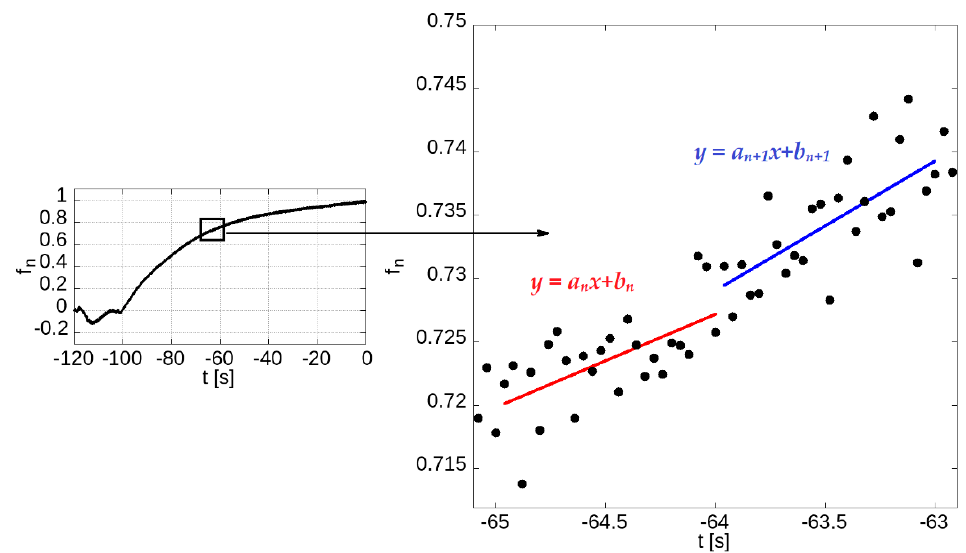
Figure 2. An example of the NADH fluorescence trace with a schematic view of the method for determining the slope coefficients a of the line (where the line equation is described by the Formula y = ax + b ) for points in neighbouring 1-s intervals. The diagram shows two examples of lines with the Equations y = a n x+b n and y = a n+1 x+b n+1 .